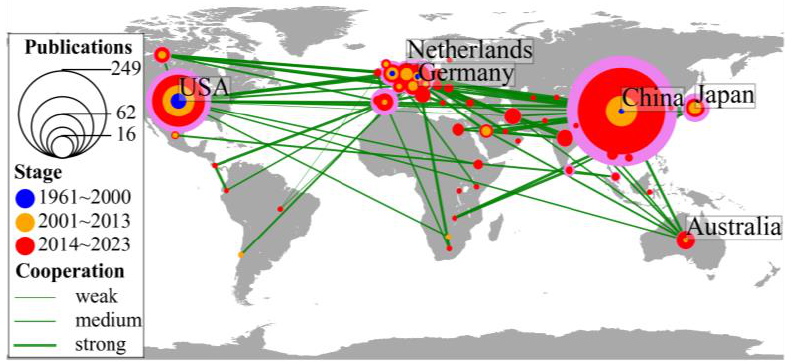
Figure 5. Cooperative network of major countries involved in DAUE.